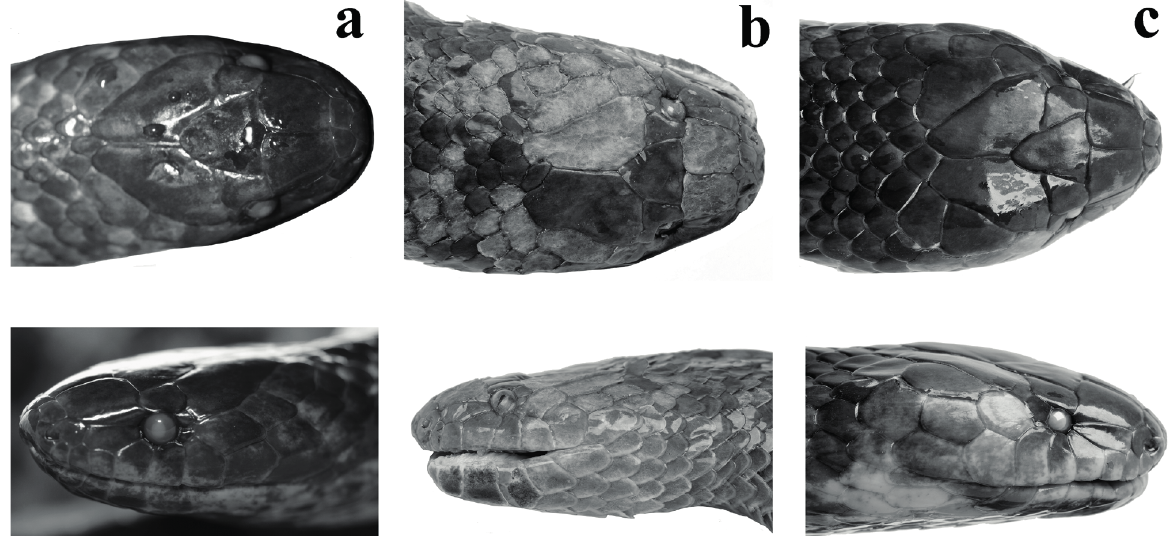
Figure 4 - Heads in dorsal (top) and lateral (bottom) views of the holotypes of Atractus atlas (mePN 14203 – a , SVl 820 mm, Cl 106 mm + N ), Atractus gigas (FHGO 194 - b , SVl 890 mm, Cl 120 mm), and Atractus touzeti (FHGO 517 – c , SVl 1035 mm, Cl 118